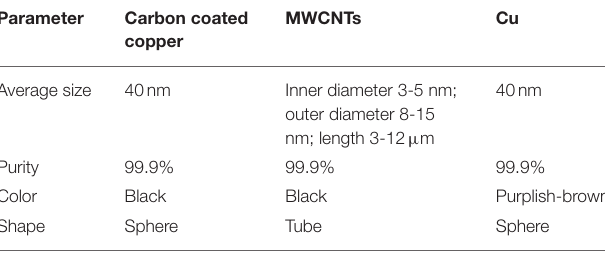
TABLE 1 | The parameters of the